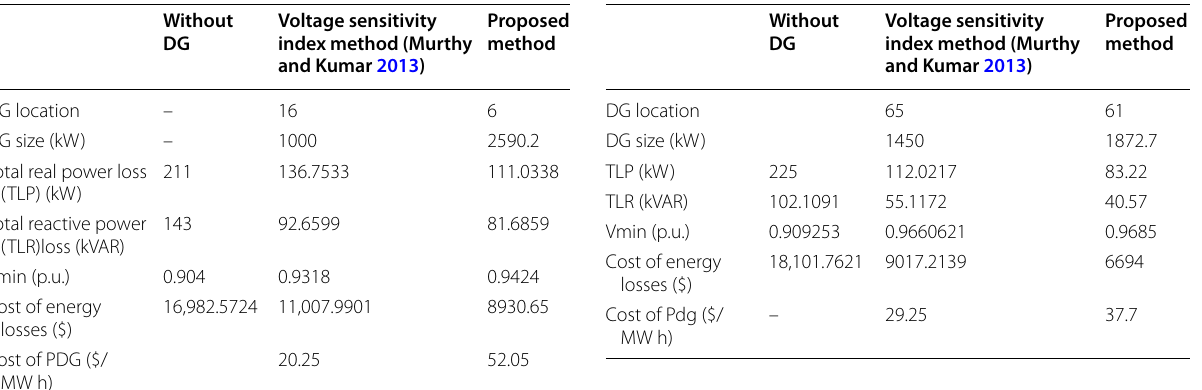
Table 5 Results for 33 bus system with DG at upf